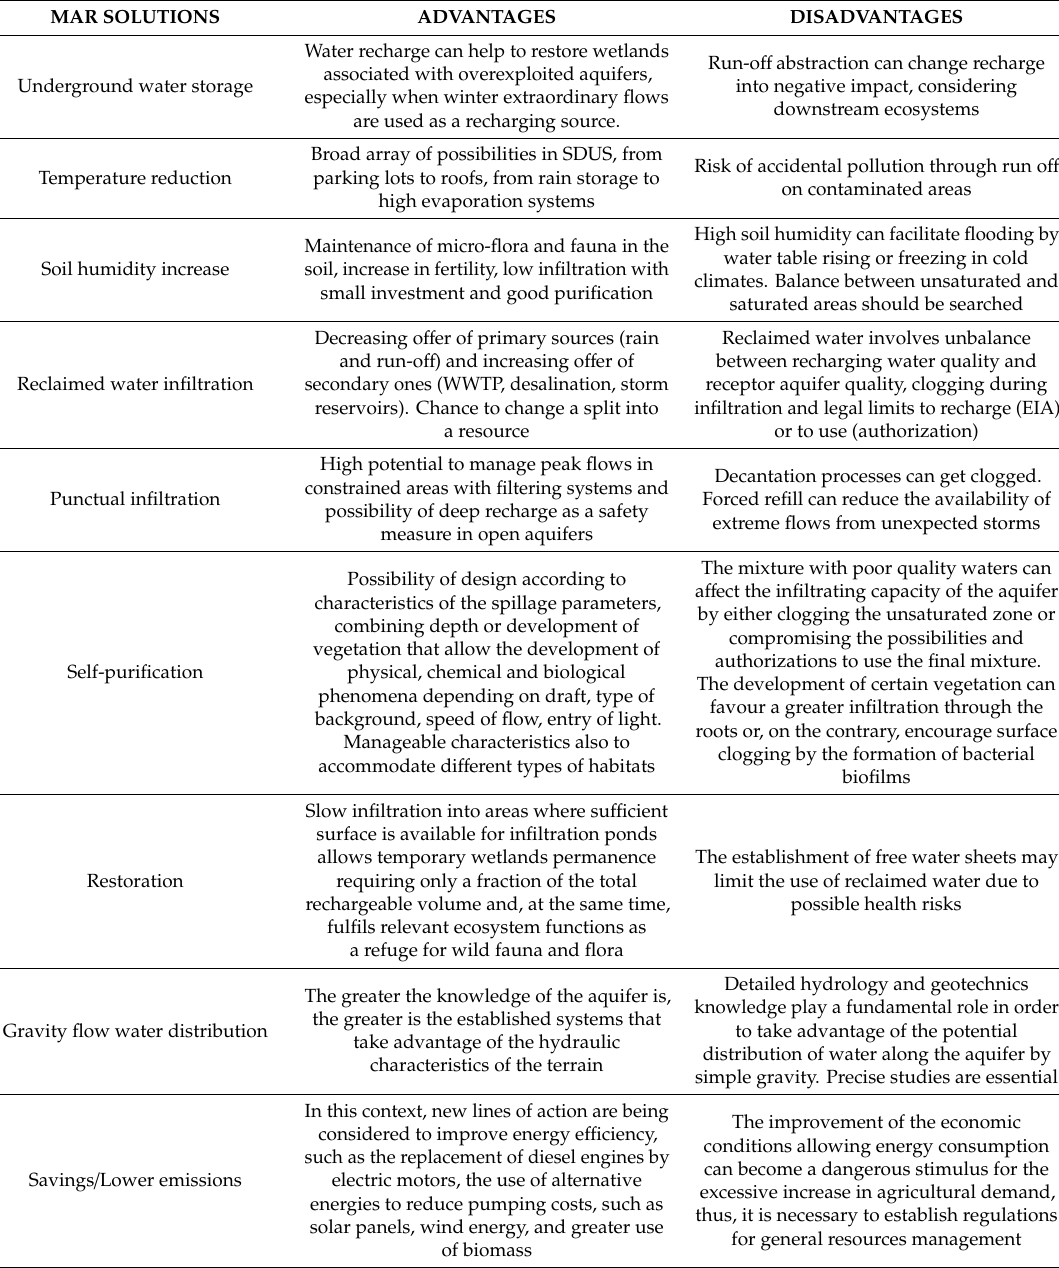
Table 2. Advantages and disadvantages of MAR technical solutions as mitigation measures of CC negative e ff